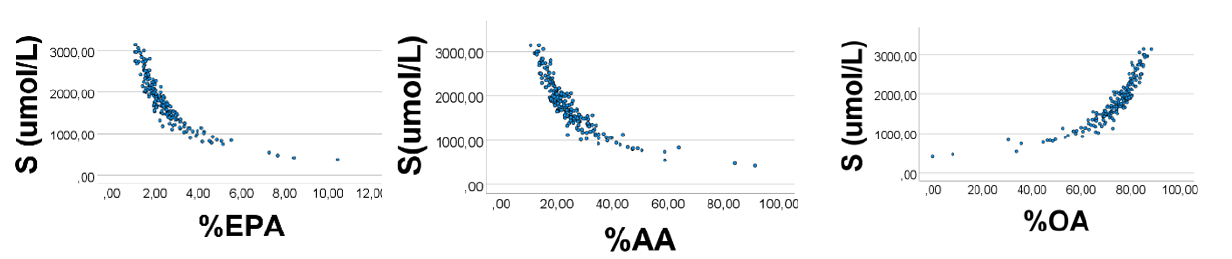
Figure 7. Computer experiment to study associations between S and relative amounts of EPA ’ , AA ’ , and OA ’ , based upon results in sera of humans [31], where S = OA ’ + EPA ’ + AA ’ . RANDOM numbers ( n = 200) were made in lieu of true values, however with the reported mean values, but using variabilities like those found in chicken muscle [32]. Spearman ’ s rho for S vs. %AA ’ (%EPA ’ ): = − 0.941 ( − 0.945); S vs. %OA ’ : rho = 0.951, p < 0.001 for all, n = 200. Note: In the figure we have omitted the random number mark ( ‘ ) on the variables.